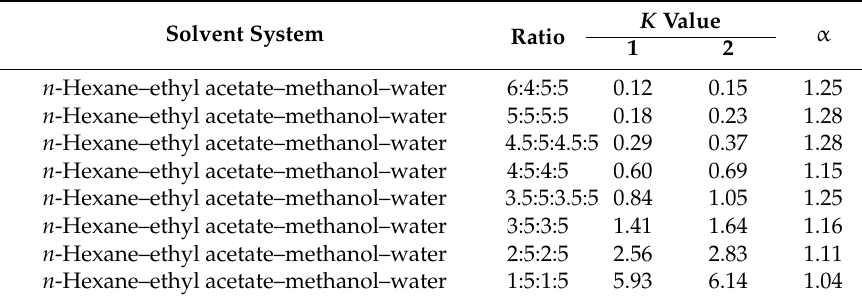
Table 1. The partition coefficients ( K ) and separation factors ( α ) of the target compounds in several solvent